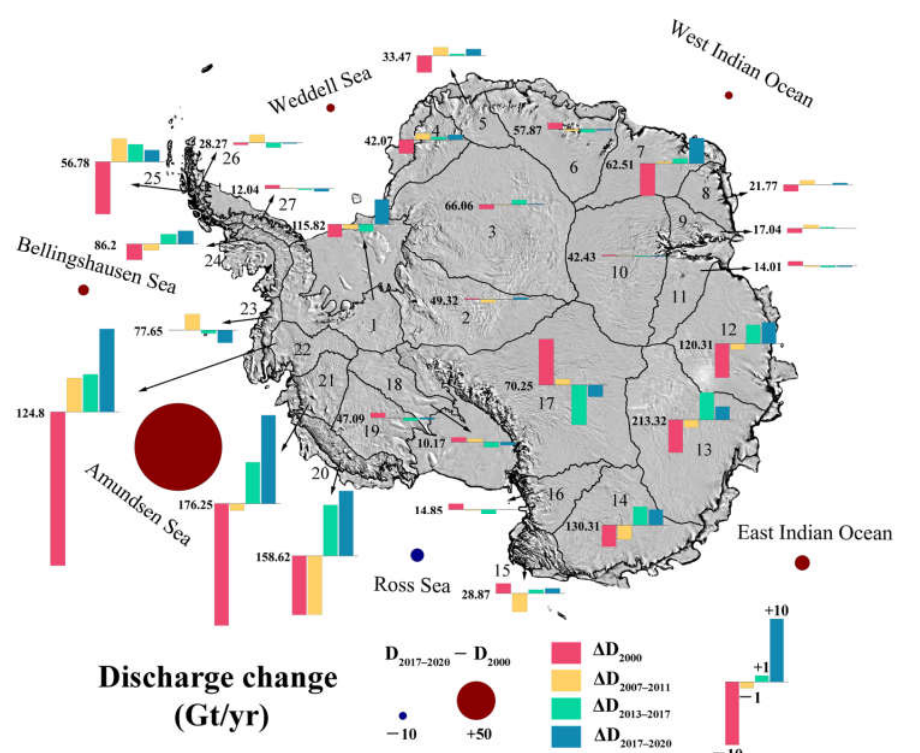
Figure 3. Ice discharge changes in different sea sectors and different basins. The bar charts show the anomaly from the mean value (left side of the bar chart) for different periods (shown in different colors). The circles show the discharge changes for different sea sectors between 2017–2020 and 2000. The bar length and the circle size are proportional to the absolute magnitude of the change in discharge. The circle colors represent the negative (blue) or positive (red) state. The base map is the MODIS mosaic of Antarctica [41], and the black lines are the basin boundaries [29].